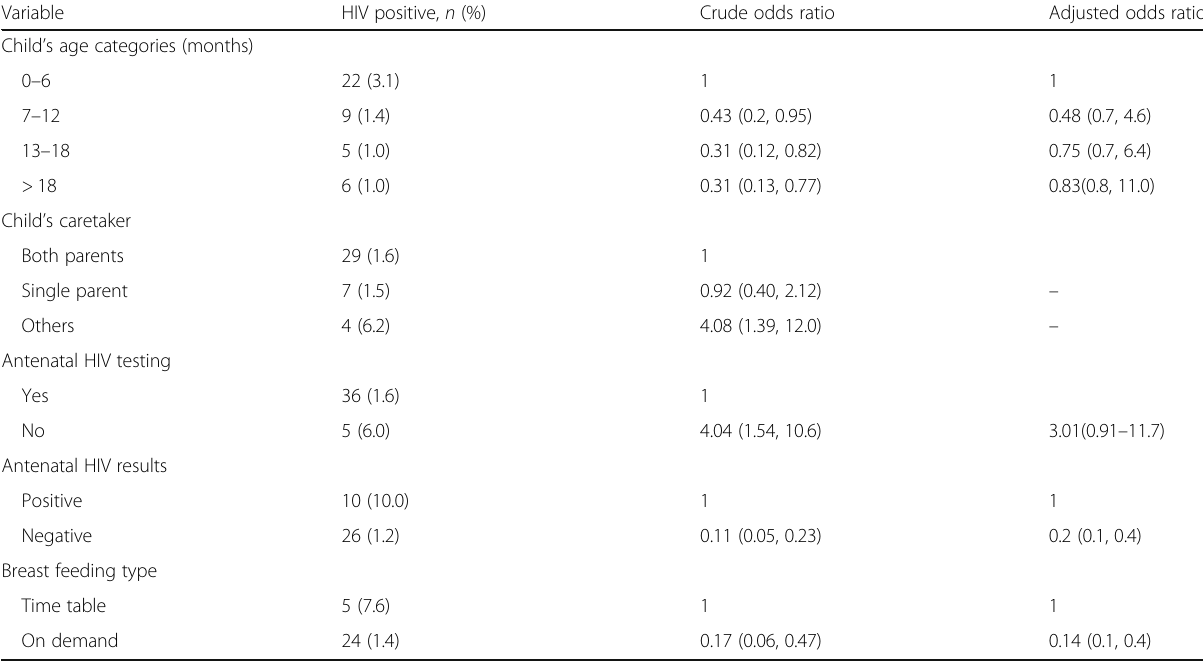
Table 3 Bivariate and multivariate analysis on factors associated with HIV among children aged 0 – 36 months in Kilimanjaro region